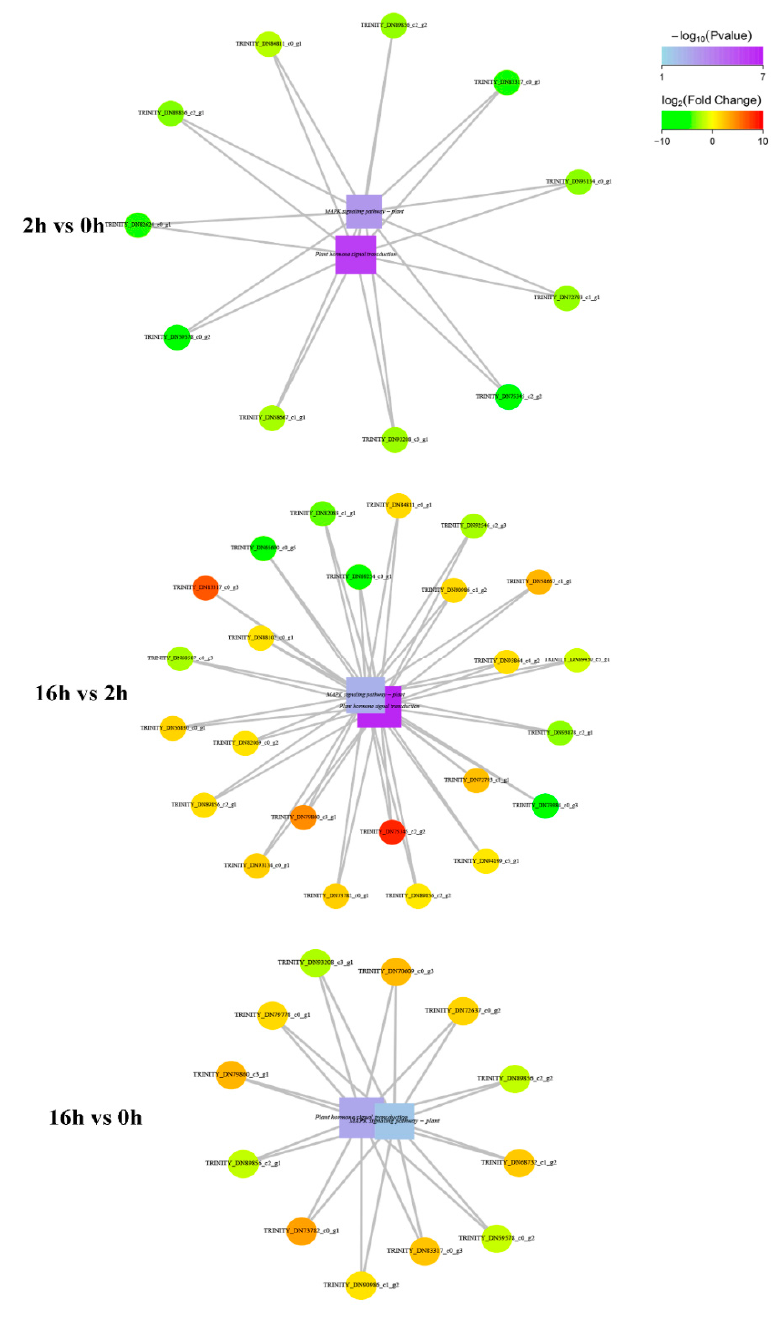
Figure 9. Each network diagram is composed of statistically significant functional and DEGs enrichments between “Plant hormone signal transduction” and the “MAPK signaling pathway-plant” in response to drought stress. The square represents functional information, circle indicates genes, and line represents the correlation between genes and functions. The color of